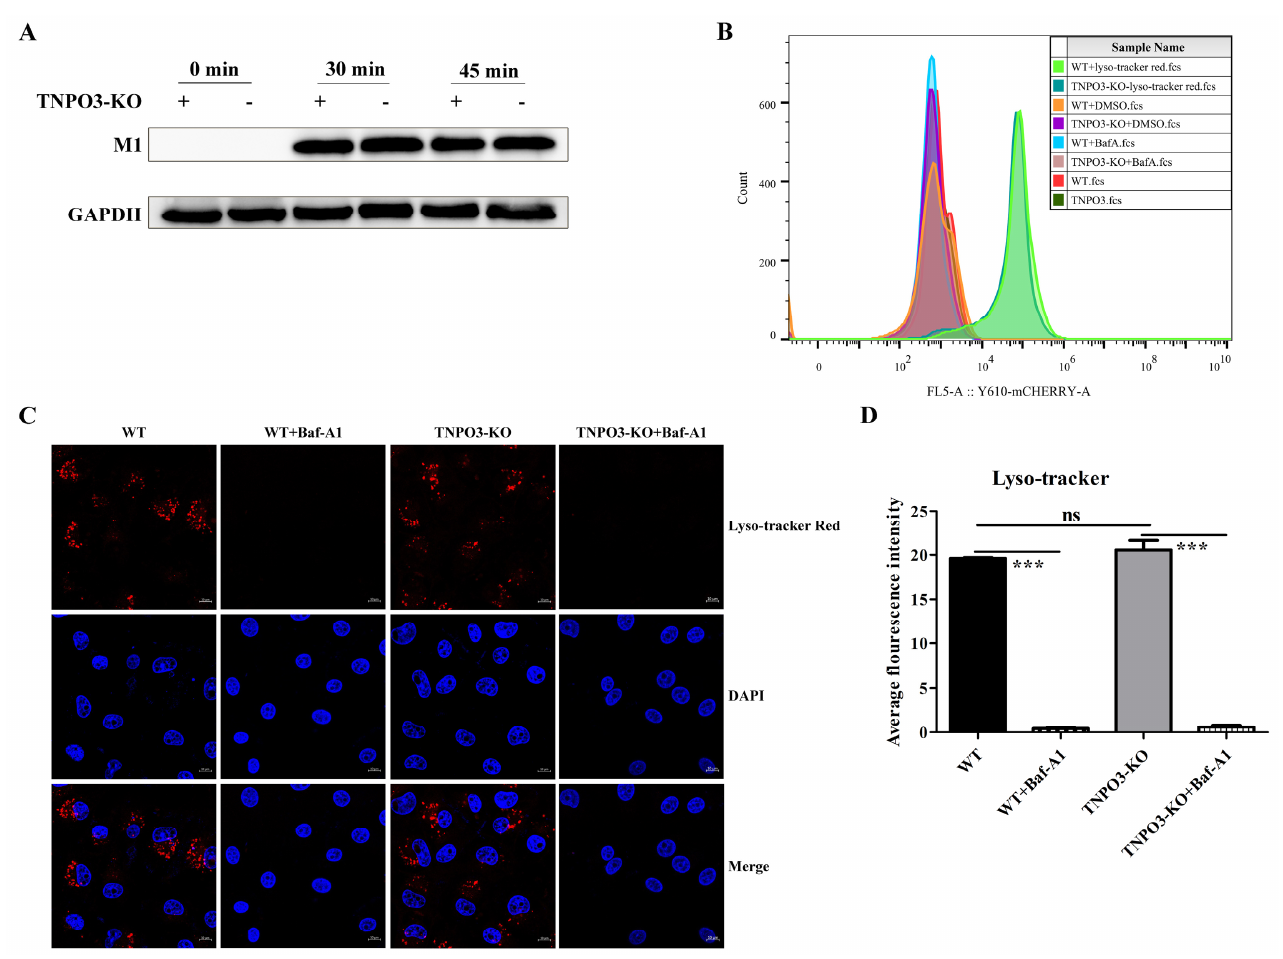
Figure 3. Knockout of TNPO3 does not interfere with endocytosis and acidification of IAV. ( A ) The effect of knockout of TNPO3 on viral endocytosis was assessed by Western blot analysis of viral M1 protein expression in infected WT and TNPO3-KO cells. ( B , C ) The effect of KO of TNPO3 on viral acidification was assessed by ( B ) flow cytometry, ( C ) confocal microscopy analysis, and ( D ) analyzing the average fluorescence intensity of two independent experiments as shown in ( C ). Baf-A1 was used as a specific inhibitor of vacuolar-type H(+)- ATPase to inhibit acidification and protein degradation in lysosomes of cultured cells. WT cells and TNPO3 KO cells were incubated either with or without Baf-A1 and then stained with Lyso-Tracker Red. Lyso-Tracker Red is a lysosome red fluorescent probe that can penetrate the cell membrane and can be used for lysosome-specific fluorescent staining of living cells. Scale bar = 10 µ m. ***, p < 0.001; Baf-A1, Bafilomycin A1; WT, wild-type; KO,